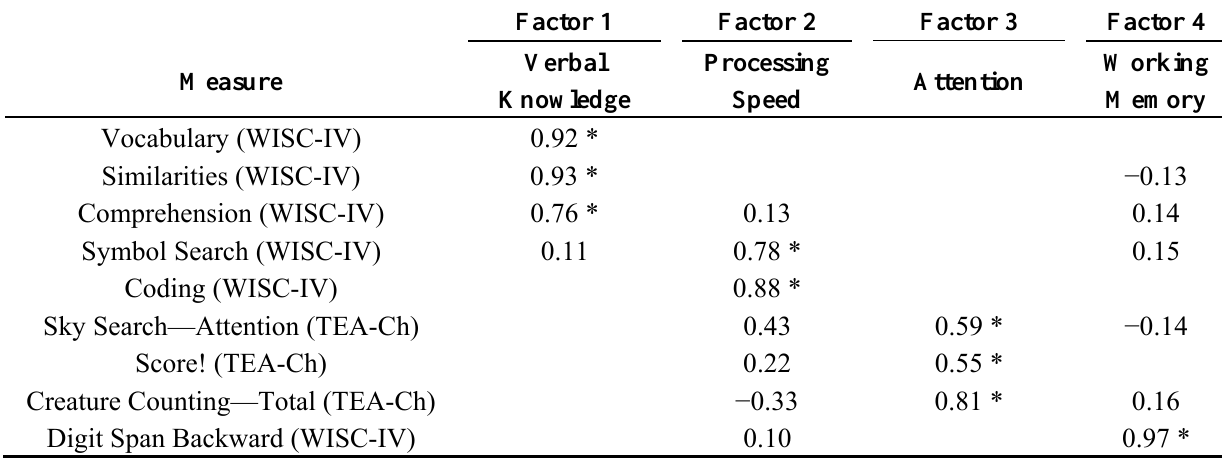
Table 2. Pattern matrix of rotated factor loadings from exploratory factor analysis.